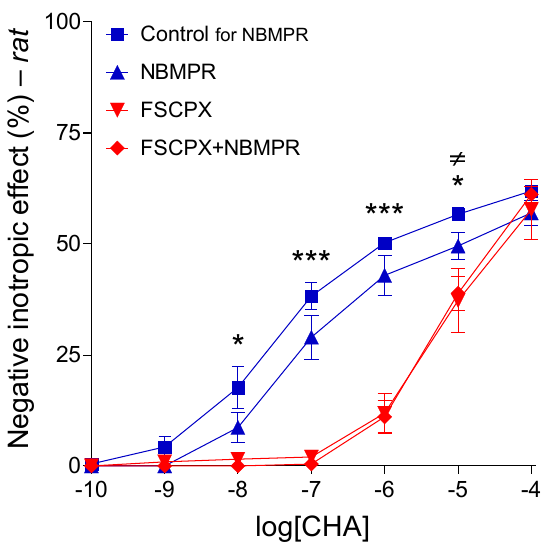
Figure 4. The direct negative inotropic effect of CHA in the isolated rat left atrium, without and with a pretreatment with 10 µ M FSCPX (administered two times, severed by a short wash-out), combined with the absence and presence of 10 µ M NBMPR. For simplicity, the Control for the FSCPX and FSCPX+NBMPR groups (not differing significantly from the Control for the NBMPR group) has been omitted. The x -axis denotes the common logarithm of the molar concentration of CHA (in the bathing medium), and the y -axis indicates the effect (as a percentage decrease in the initial contractile force). The symbols show the responses to the agonists averaged within the groups ( ± SEM). The blue and red E/c curves refer to the absence and presence of an FSCPX pretreatment, respectively. FSCPX: 8-cyclopentyl- N 3 -[3-(4-(fluorosulfonyl)benzoyloxy)propyl]- N 1 -propylxanthine; NBMPR: S -(4-nitrobenzyl)-6-thioinosine; CHA: N 6 -cyclohexyladenosine; E/c: concentration–effect; *: comparison of the Control for the FSCPX and FSCPX+NBMPR groups (data not shown) with the FSCPX group as well as FSCPX+NBMPR group (indicated on the CHA E/c curve of the Control for the NBMPR group); ≠ : comparison of the Control for the NBMPR group with the NBMPR group; the number of marks means the level of statistical significance (one mark: p < 0.05, three marks: p < 0.001).